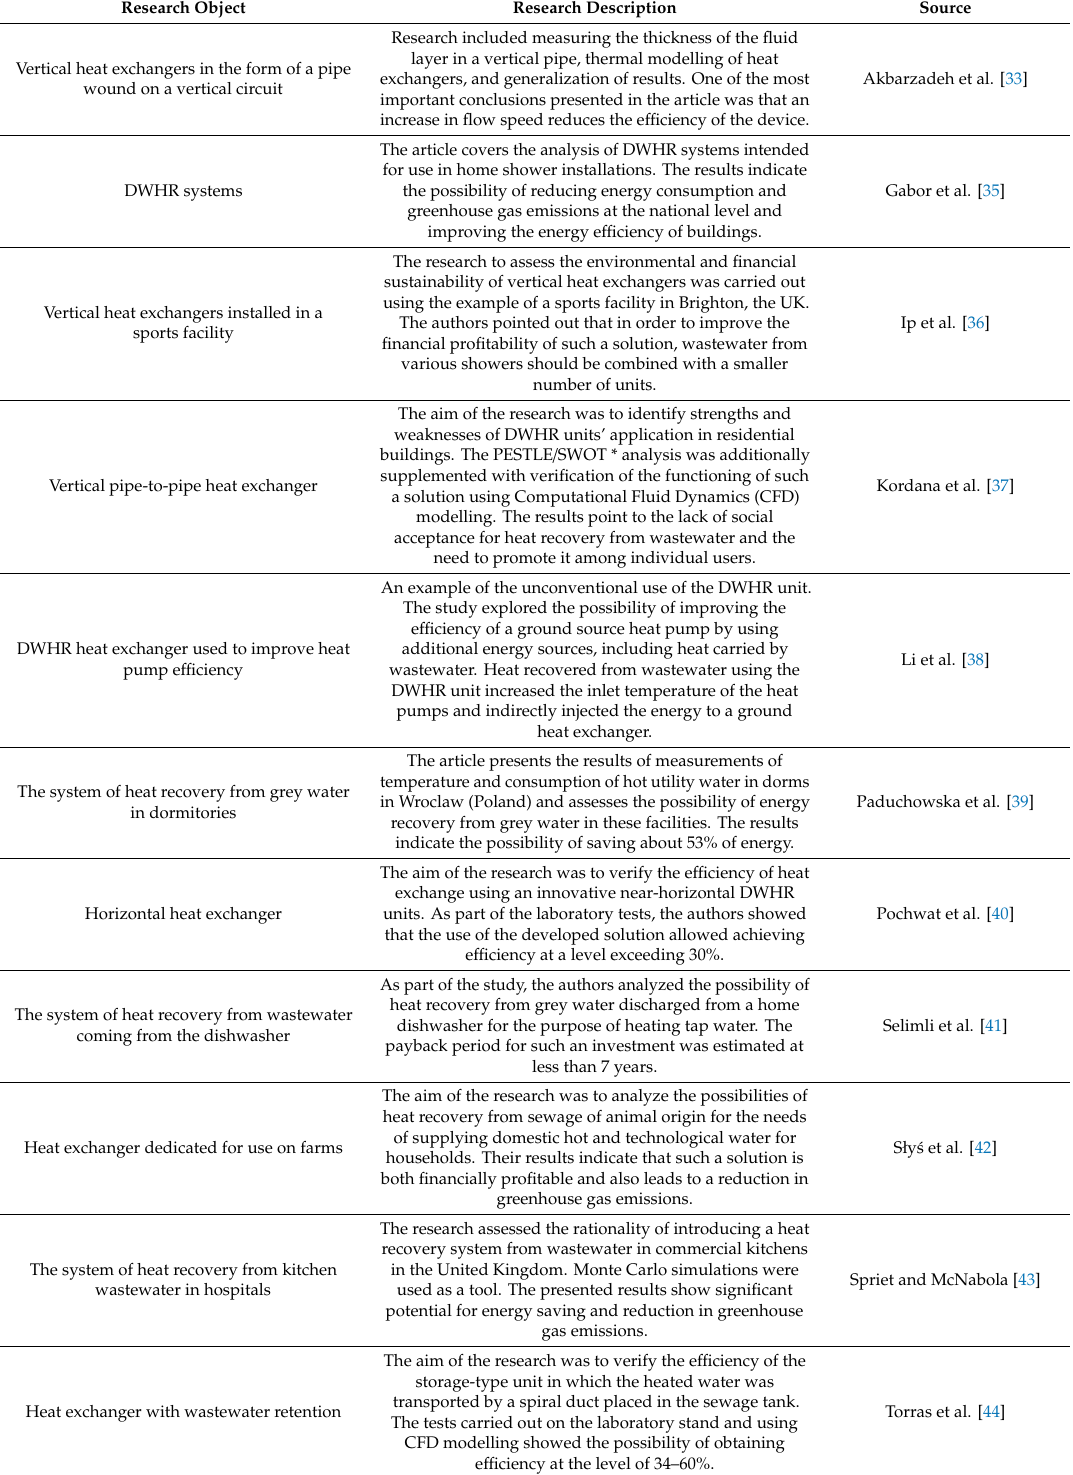
Table 1. The examples of research in the field of heat recovery from